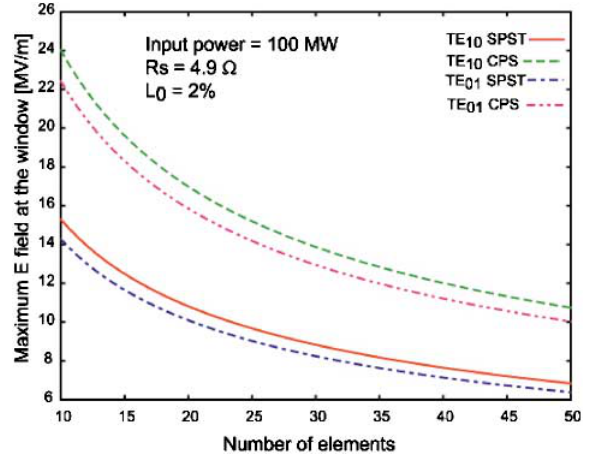
FIG. 8. (Color) Acceptable loss versus necessary number of